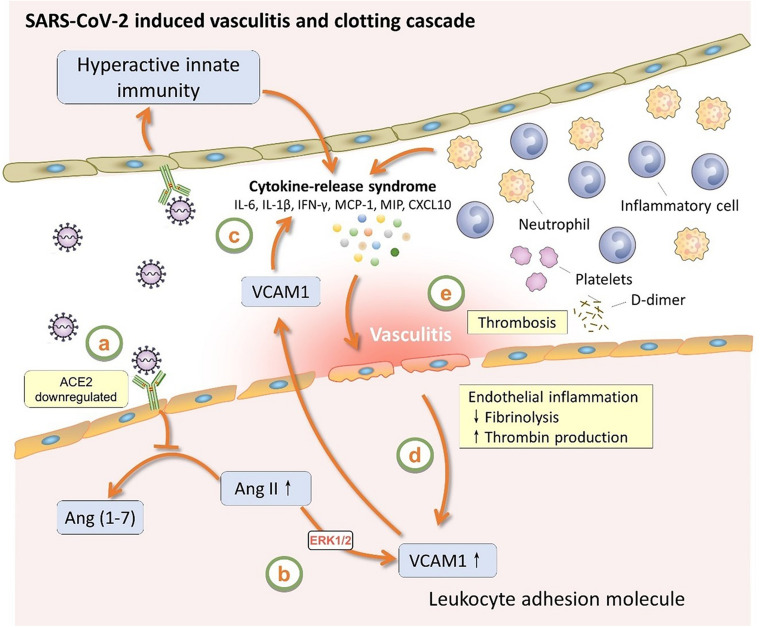
The role of VCAM1 in SARS-CoV-2 induced vasculitis and clotting cascade. VCAM1, vascular cell adhesion molecule 1; ACE2, angiotensin-converting enzyme 2; Ang II, angiotensin II; Ang (1–7), angiotensin (1–7); ERK1/2, extracellular signal-regulated kinase 1/2; IL-6, interleukin-6; IL-1β, interleukin-1β; IFN-γ, interferon-γ; MCP-1, monocyte chemoattractant protein-1; MIP, macrophage inflammatory protein.